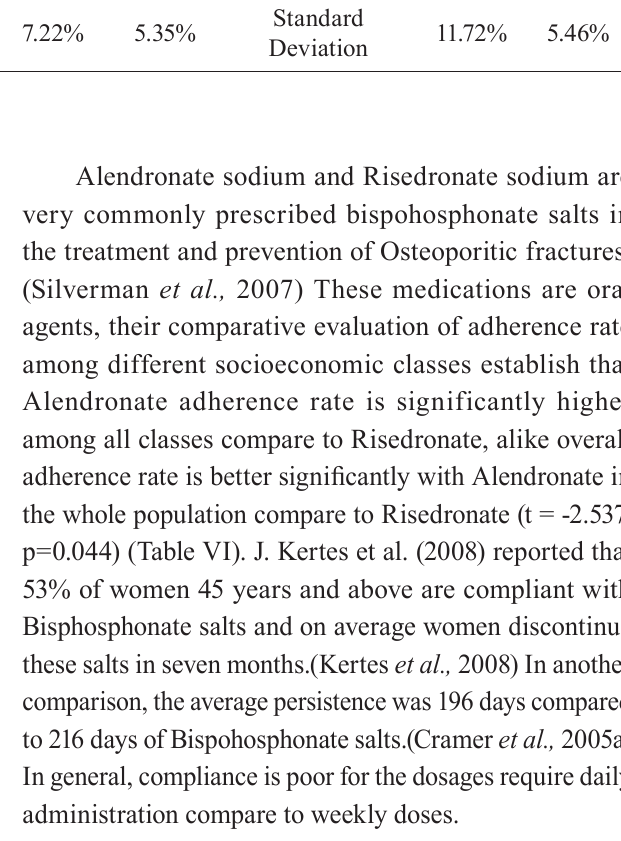
38 = N ( up s o r G